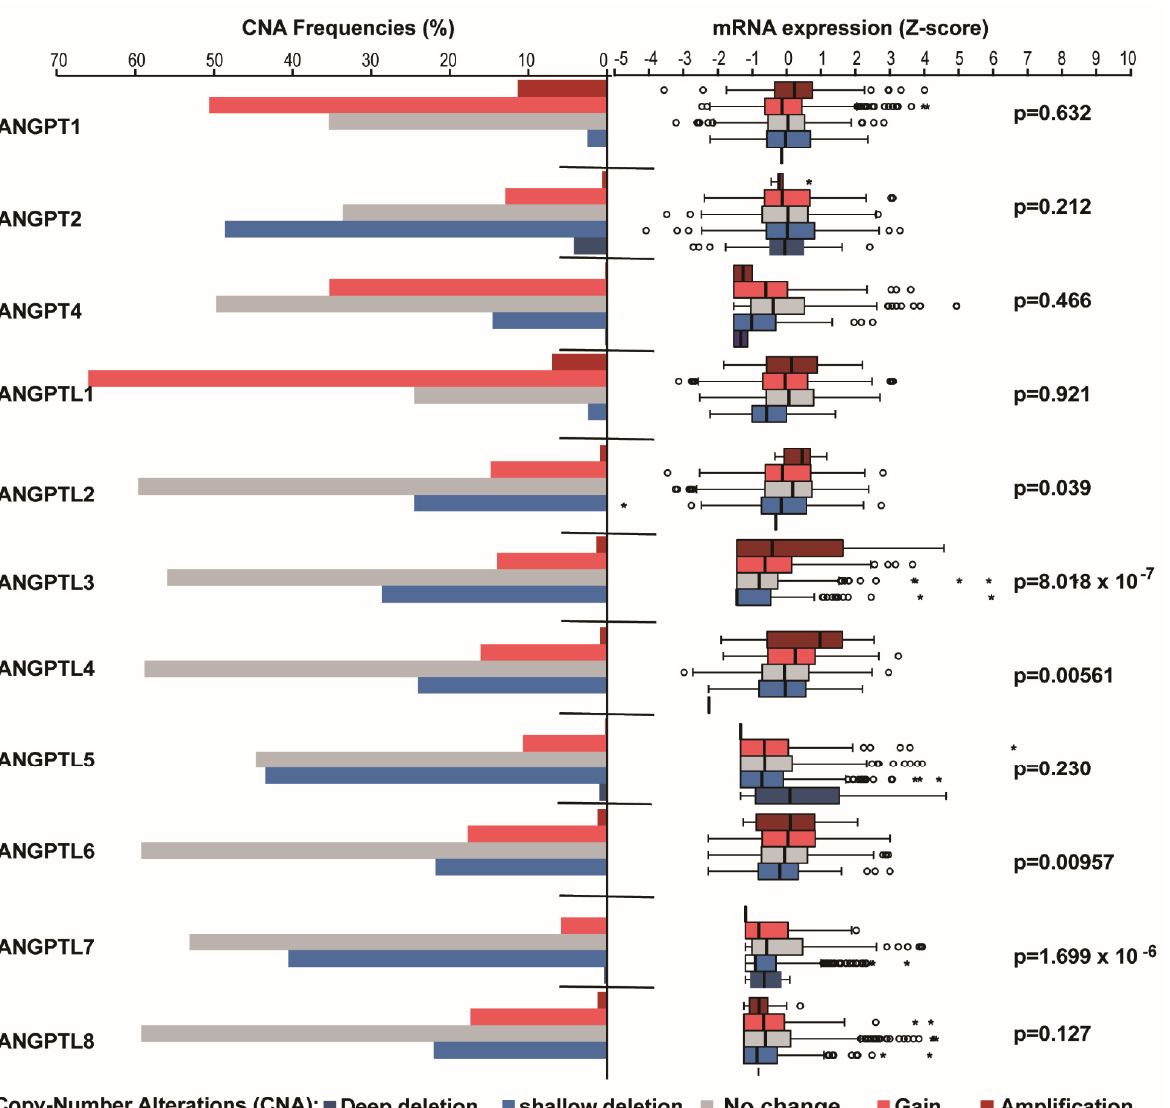
Figure 2. Correlation between DNA copy number of ANGPT / ANGPTL genes and their transcriptional expression in TCGA-BRCA. Left panel: frequency of DNA copy number alteration (CNA) in ANGPT / ANGPTL genes. Right panel: box plot of the relationship between DNA copy number and gene expression for ANGPT / ANGPTL genes in BCs. Stars indicate extreme outliers while circles indicate mild outliers. The p -values were obtained from Spearman correlation analysis between gene DNA copy number and expression.